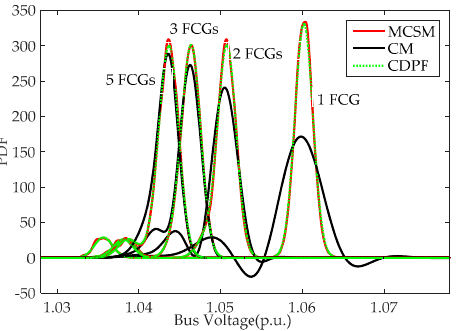
Figure 9. The PDFs of the voltage magnitude at bus-14 with one, two, three and five FCGs, respectively, at different buses in an IEEE 14-bus power system.